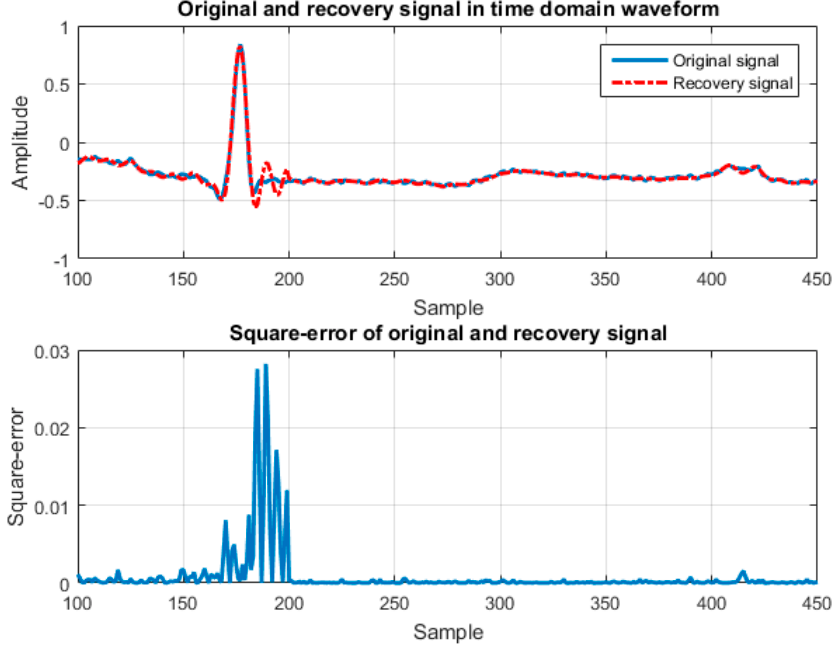
Figure 1. Square error of signal window when using the compressed sensing (CS) algorithm proposed in [9].